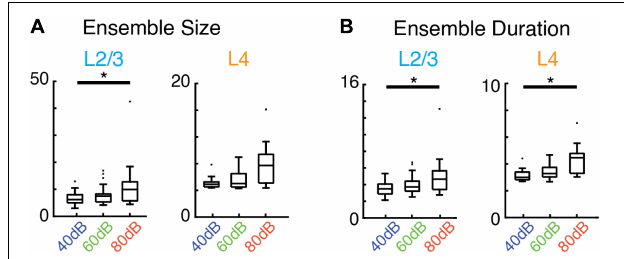
FIGURE 5 | Average activity ensemble size and duration depend on sound level. (A) Boxplots showing average ensemble size in L2/3 (left; p < 0.04, asterisk indicates significant difference at ∗ p < 0.05) and L4 (right) as a function of sound level. (B) Conventions as in (A) , but for average ensemble duration (L2/3 p < 0.04, L4 p < 0.03, asterisk indicates significant difference at ∗ p <